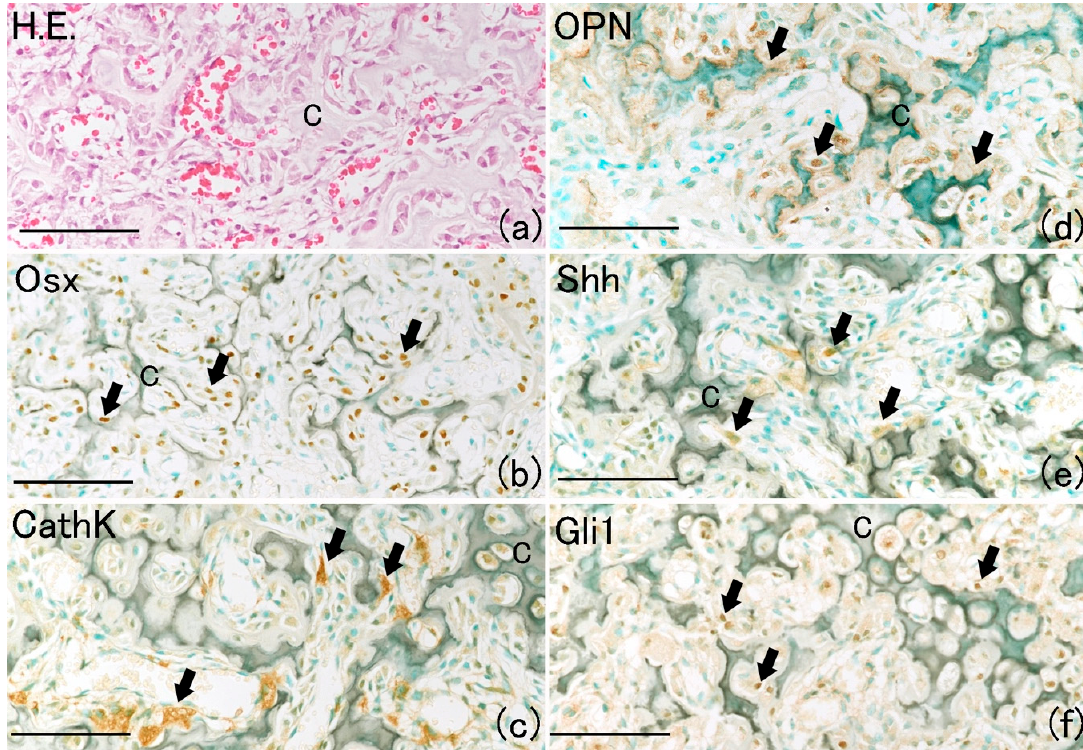
Figure 7. Histological analysis at day 14 on rat lib bone fracture. ( a ) Reduction of formed cartilage matrix began to resorb and be replaced by new bone formation on rat lib bone fracture. ( b ) Osx-positive cells were observed around reduced cartilage matrix (arrows). ( c ) Localization of CathK-positive cells was around remaining cartilage matrix. ( d ) OPN-positive area was observed around the cartilage matrix. ( e ) Shh-positive areas localized around cartilage matrix (arrows). ( f ) Gli1-positive areas found around cartilage matrix (arrows). (NB: newly formed bone; C: cartilage; Scale bar: 50 μ m).